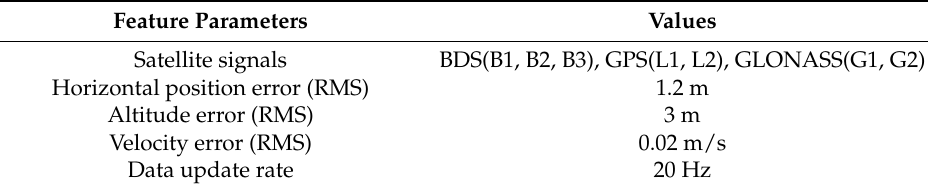
Table 4. Main parameters of Hemisphere P307 BDS/GNSS receiver.